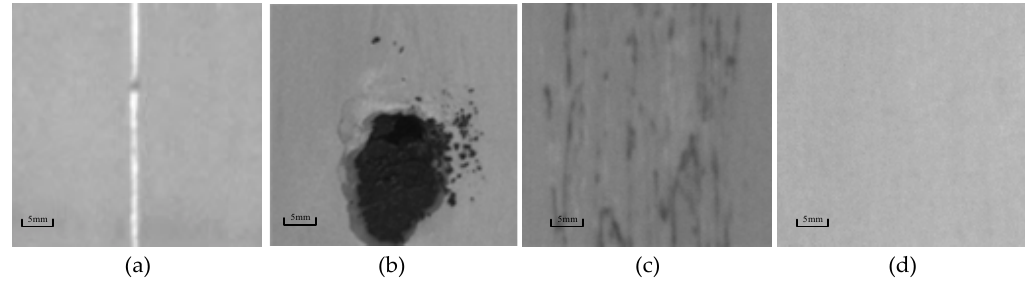
Figure 12. Four defect types: scratches ( a ), slags ( b ), peels ( c ), no defects ( d ).